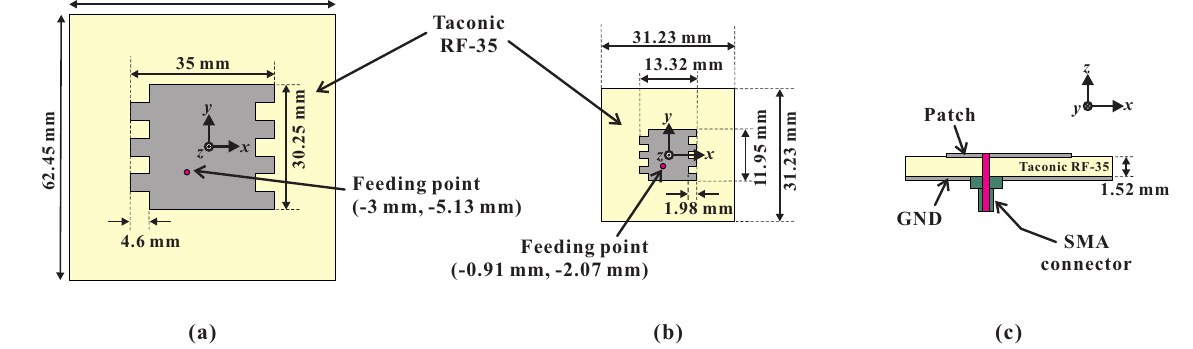
Figure 3. Radiating elements: ( a ) 2.4 GHz RHCP (right-handed circular polarization) patch; ( b ) 5.8 GHz RHCP patch; ( c ) sideview of the patches.